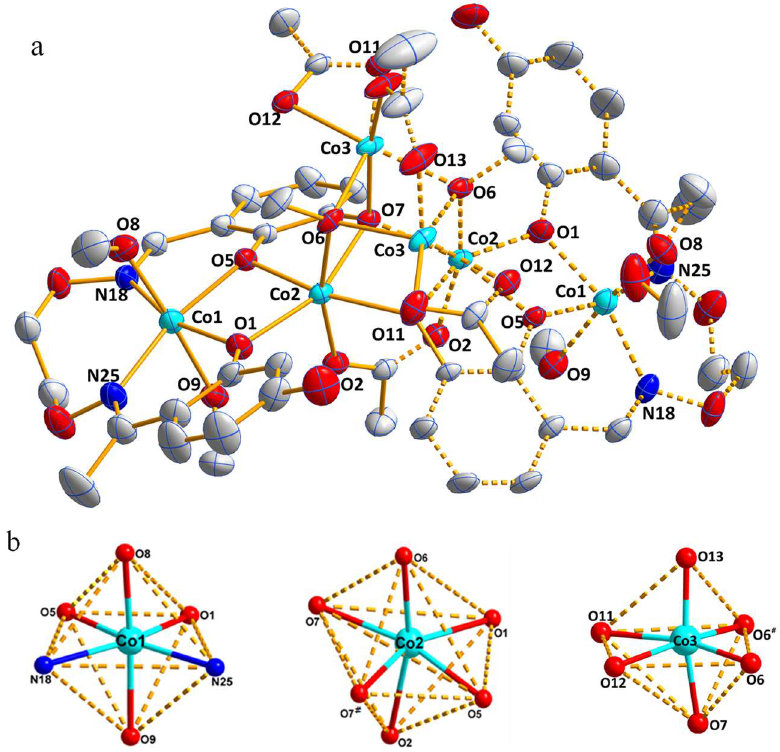
Figure 1. ( a ) Crystal structure and atom numberings of the Co(II) coordination compound; ( b ) Coordination polyhedrons for Co(II) atoms.